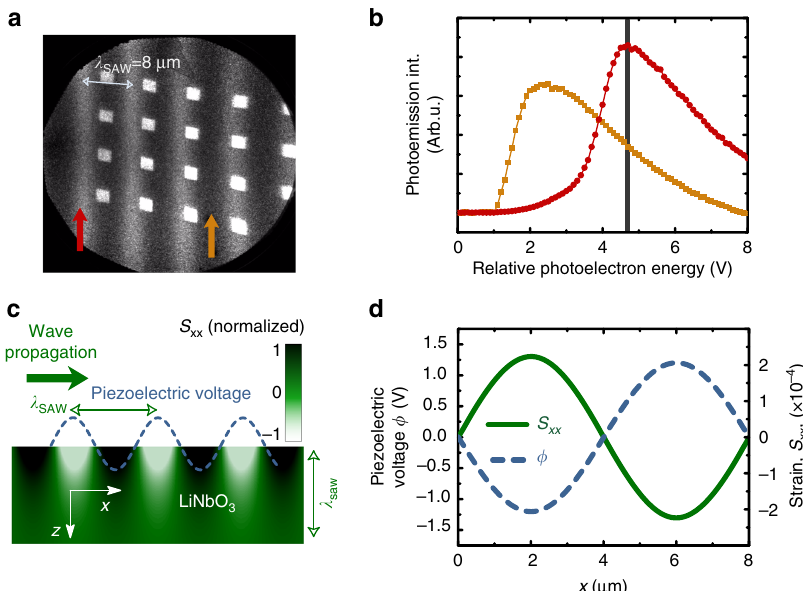
Fig. 2 Images of SAW. a PEEM image of multiple Ni squares of 2 × 2 μ m 2 with a fi eld of view of 50 μ m recorded at a photoelectron energy of 4.8 V. The piezoelectric voltage produces periodic dark and bright zones in the PEEM image with the periodicity of the SAW, λ SAW = 8 μ m. b Two photoelectron energy scans of the photoemission intensity corresponding to a bright and a dark zone (indicated in a with red and orange arrows ). The vertical line indicates the electron energy at which a was acquired. c Schematic plot of the in-plane strain (in green colorscale ) induced modulation in the LiNbO 3 caused by the acoustic wave. Dashed blue line indicates the oscillating piezoelectric voltage modulation. d Calculation of the in-plane strain component ( right hand side axis ) and the piezoelectric voltage ( left hand side axis ) at the sample surface for a SAW with a λ SAW = 8 μ m wavelength. Calculations of the strain are done to match the measured piezoelectric voltage of a . The magnetization changes are driven basically by the in-plane strain component along the SAW propagation direction. The piezoelectric voltage is in phase with the in-plane strain component, albeit with an opposite